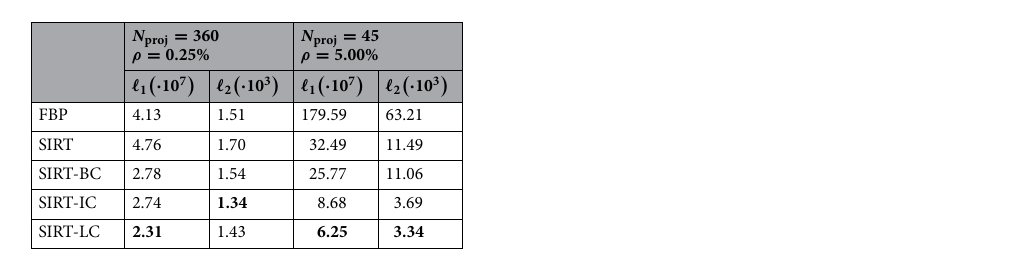
Table 2. Table of the ℓ 1 - and ℓ 2 -norms for the best and worst data case. Bold numbers indicate the best performing